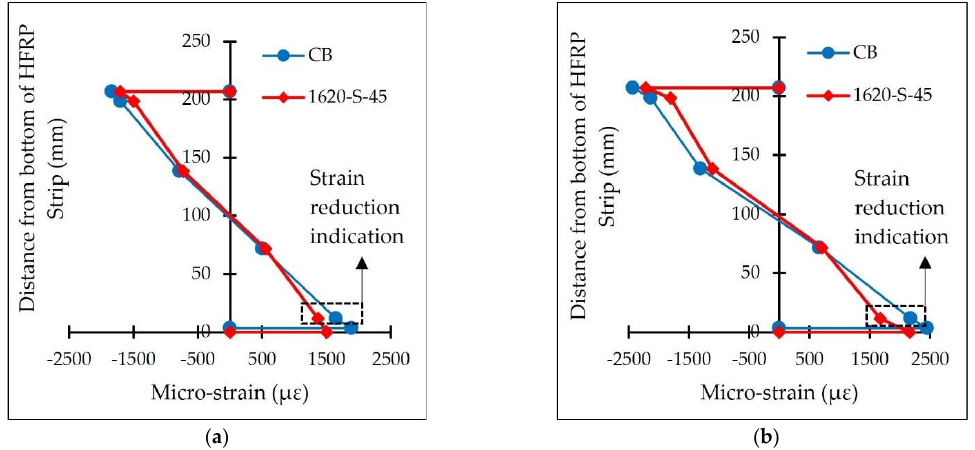
Figure 17. Strain profiles at the mid-segments of CB and 1620-S-45 at: ( a ) 250 kN; ( b ) 310 kN.